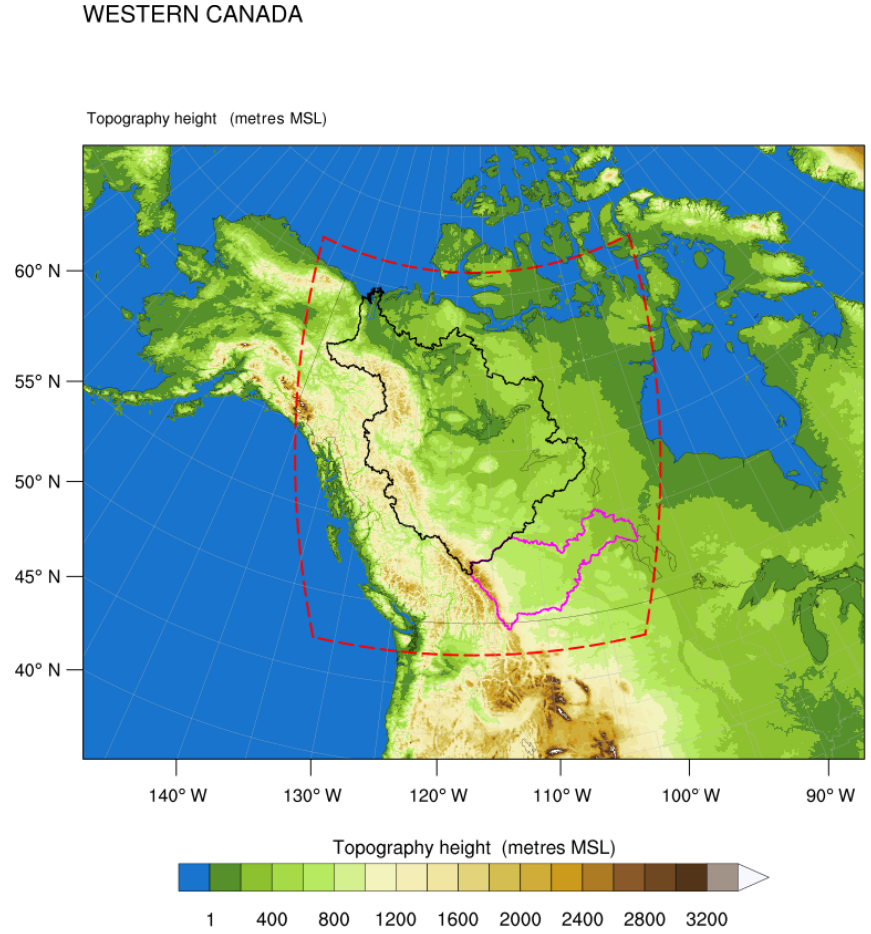
Figure 1. WRF simulation domain (2560km × 2800km) at 4km grid spacing showing topographic height in metres above mean sea level (ma.m.s.l.). The simulation domain is indicated by a red frame. The bold pink and black polygons represent the Mackenzie River basin (MRB) and the Saskatchewan River basin (SRB),